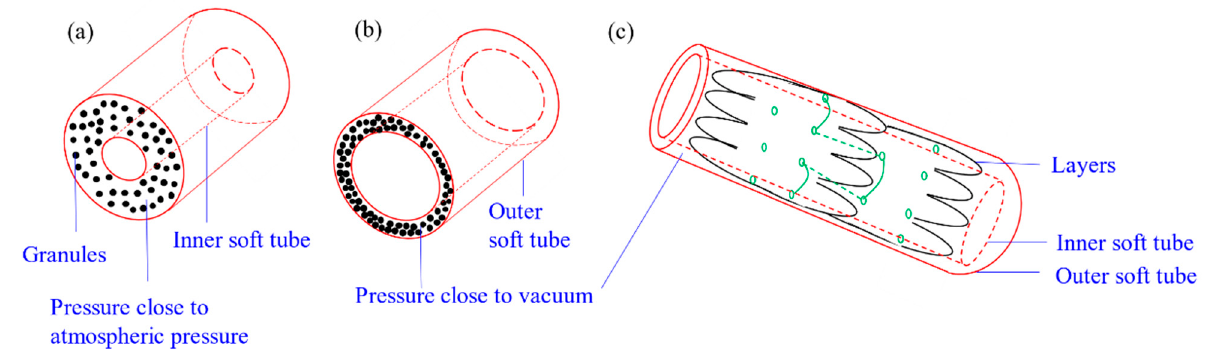
Figure 18. Working principles of the granule jamming and layer jamming: ( a ) A soft tube before vacuum, ( b ) a stiffening tube after vacuum with granules jamming and ( c ) a stiffening tube after vacuum with layer jamming.